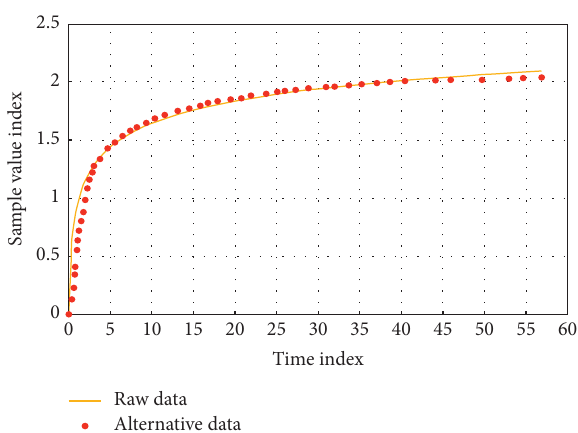
Figure 6: Statistical analysis of original data and alternative data under null hypothesis